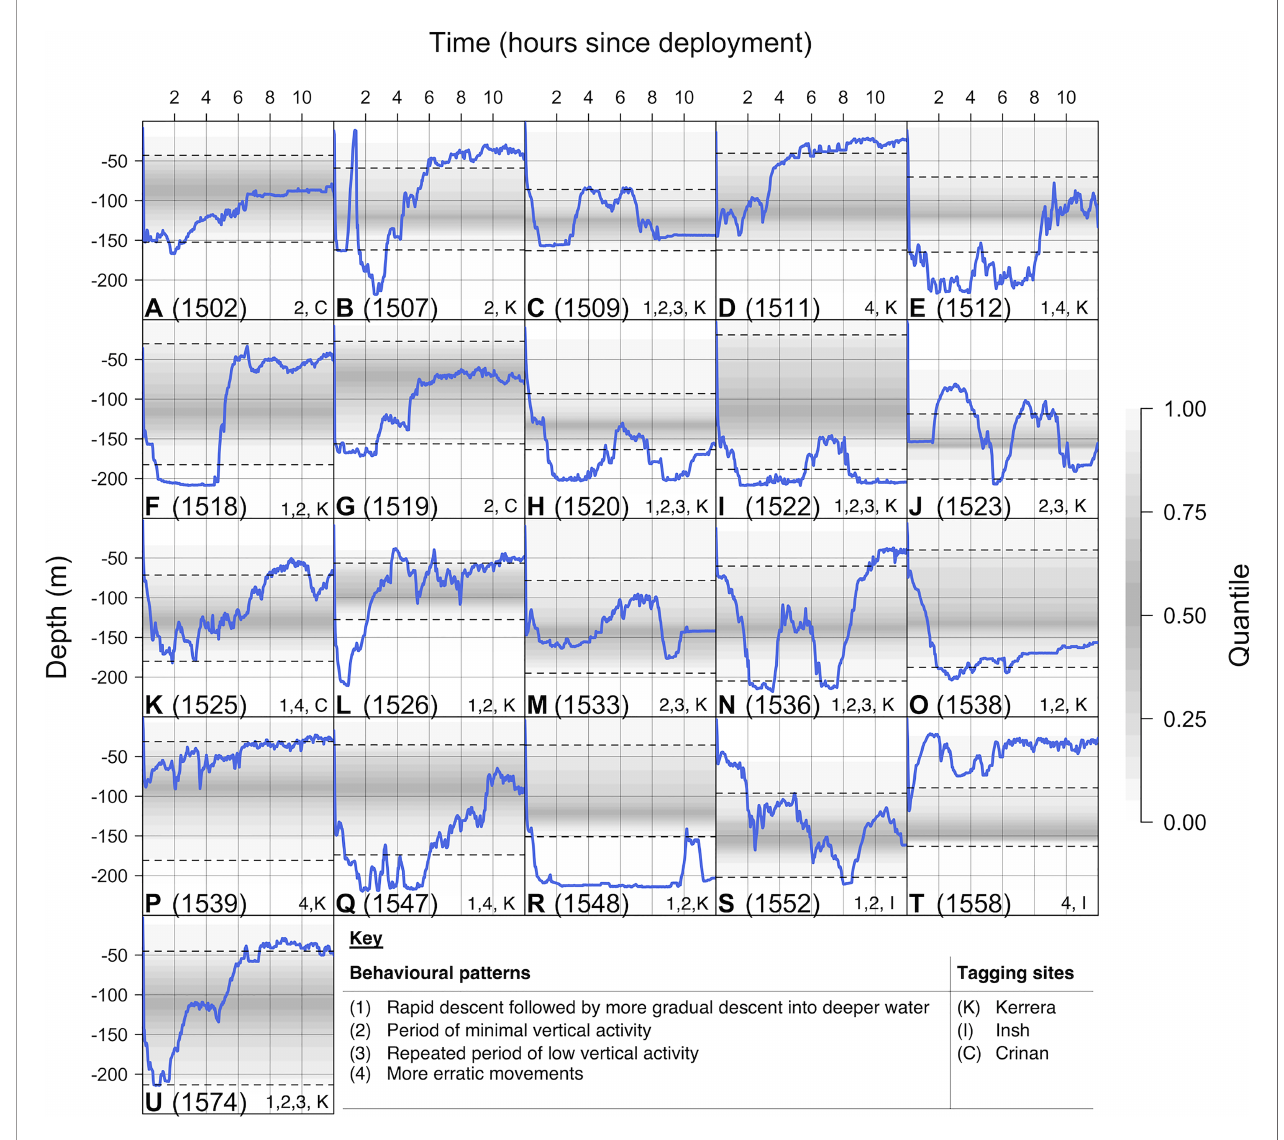
FIGURE 4 | Depth time series following tag deployment. Each plot (A – U) shows the observed time series (in blue) for a speci fi c individual. The background shading marks the quantiles of observed variation in depth based on the rest of each individual ’ s time series, with quantiles near the middle of the distribution shaded more darkly than quantiles towards the edge of the distribution. The dashed lines mark the 25 th and 75 th quantiles respectively. Depth observations beyond these lines are considerably shallower or deeper than average, while depth observations beyond the shading are more extreme than observed outside of capture event(s). Numbers and letters mark distinct patterns and tagging locations,